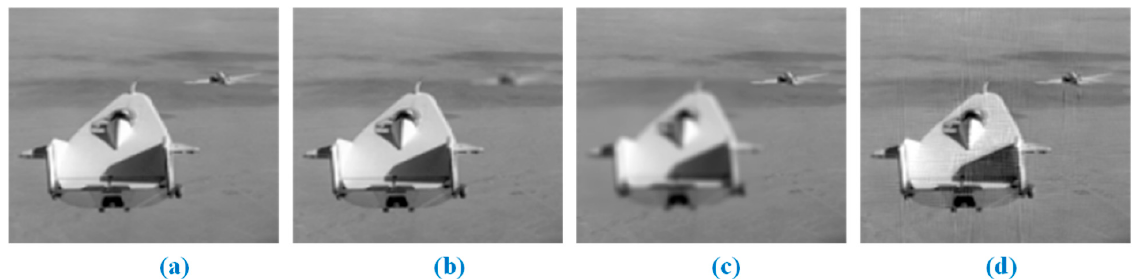
Figure 7. (Wine): ( a ) Original Image; ( b , c ) Multi-focus input images; ( d ) Proposed fusion.